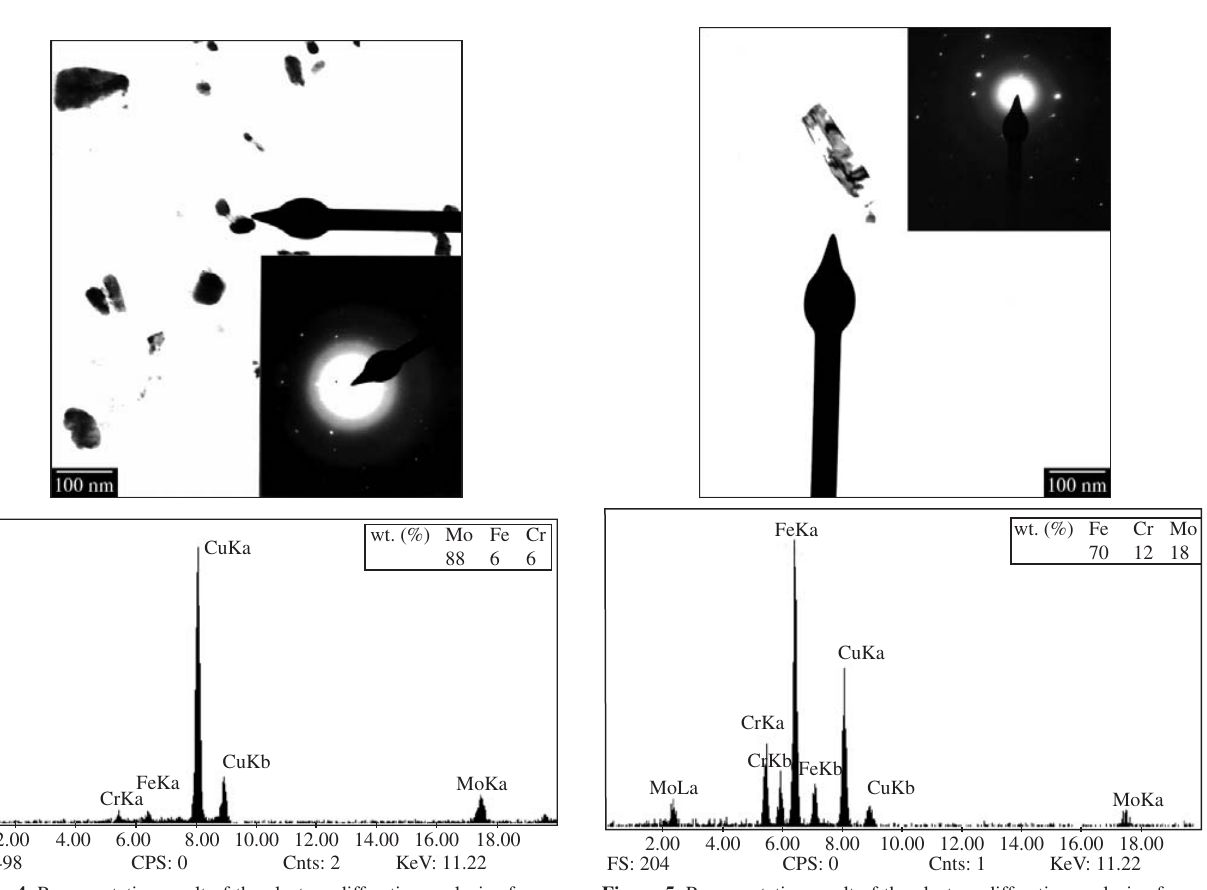
Figure 4. Representative result of the electron diffraction analysis of a se- lected area (carbide extraction replica) and of the EDS spectrum of uniform fine M C-type precipitates. 2